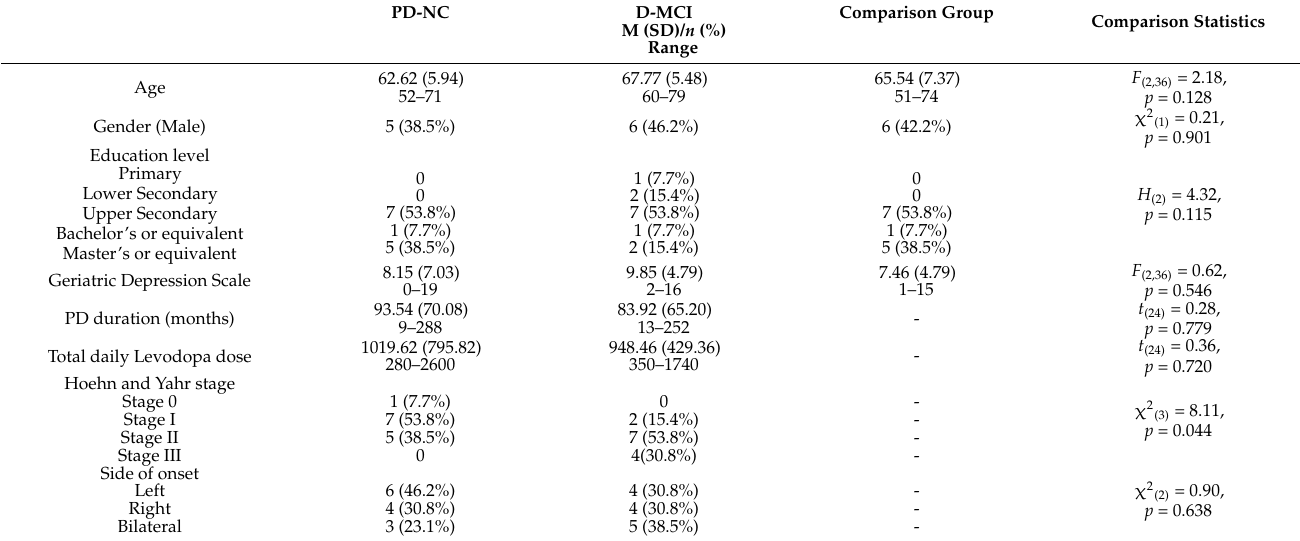
Table 2. Demographic information, clinical characteristics, and cognitive functioning in division into 3 groups.